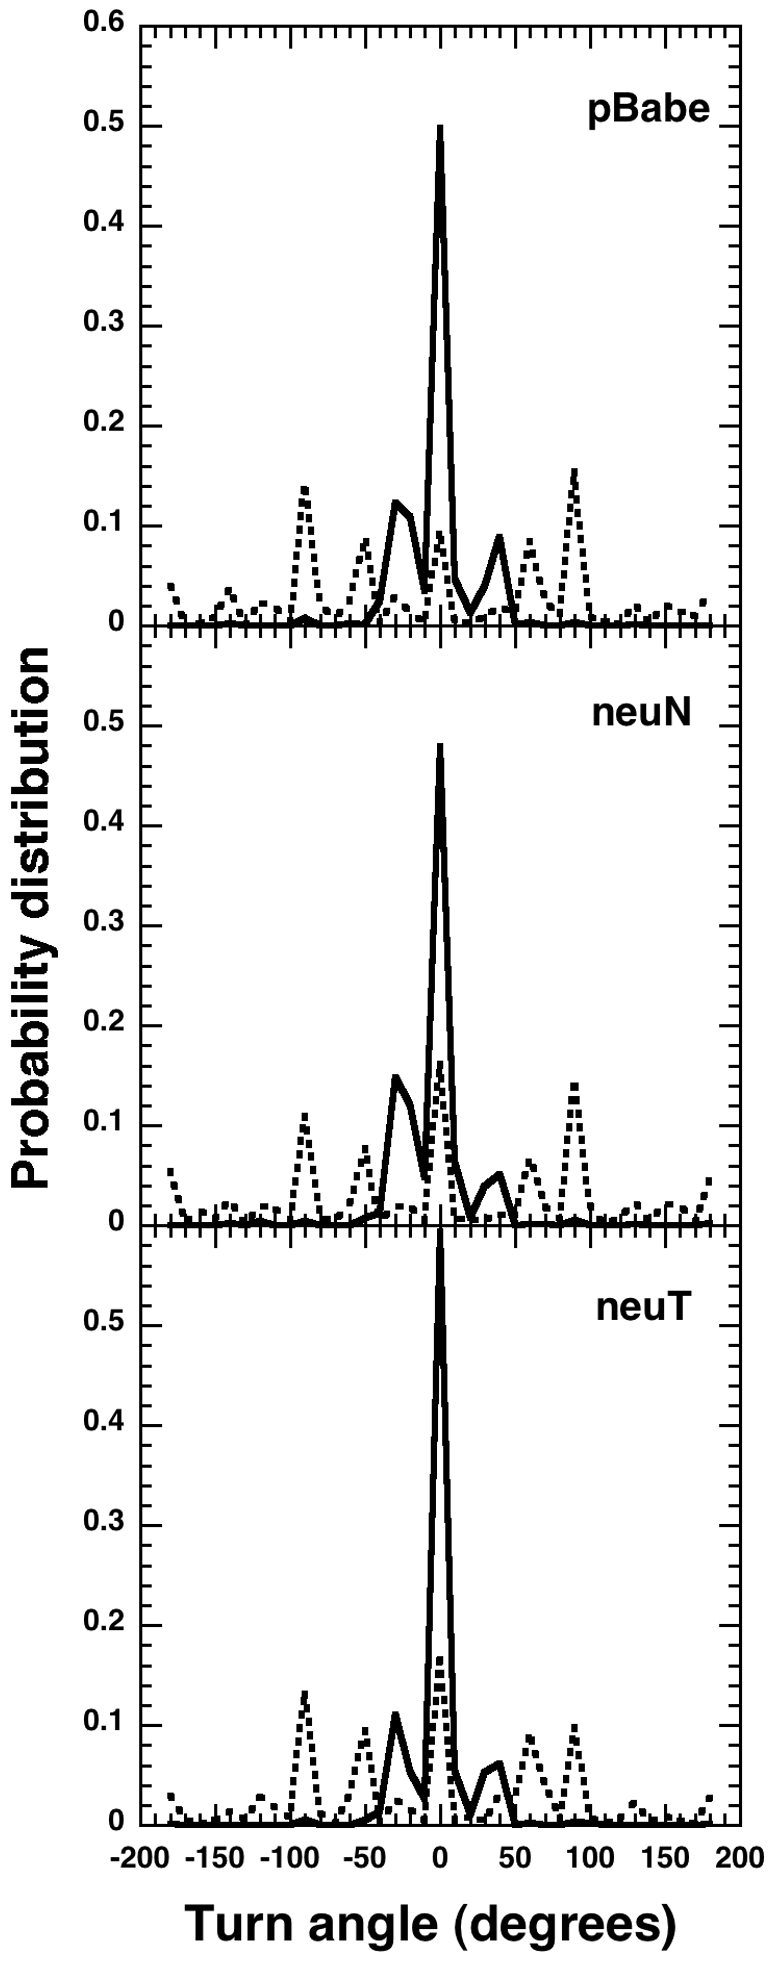
Probability distributions of the turn angles within the directional and re-orientation flights.
Top, pBabe, middle, neuN and bottom, neuT cells. The solid line shows the turn angle distribution during directional flights while the broken lines during re-orientation flight. The directional flights display higher persistence compared to the re-orientation flights that have a more flatter turn angle distribution.